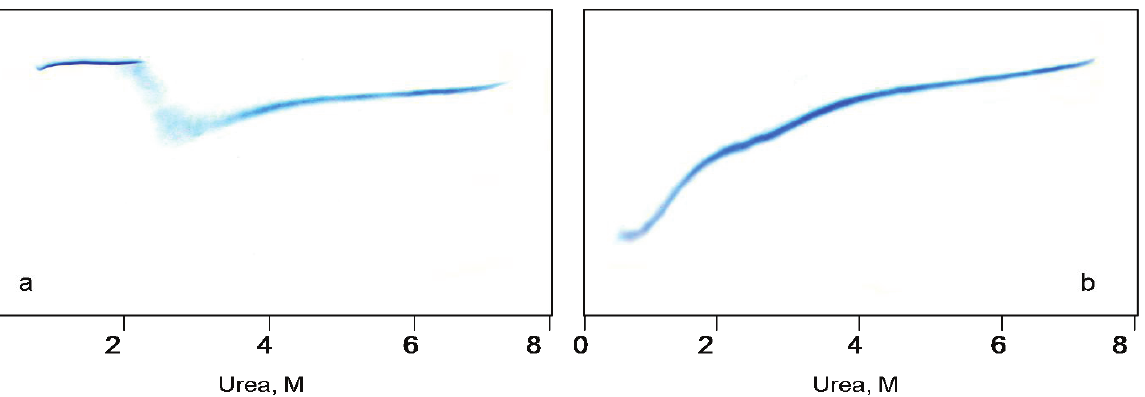
Figure 1. Urea transverse gradient gel-electrophoresis of GroEL. ( a ) Denaturation. Native GroEL (C = 0.5 mg/mL) solution in 20 mM Tris-HCl, pH 7.5 was loaded on the gel; ( b ) Renaturation. Unfolded GroEL (C = 0.5 mg/mL) solution in 20 mM